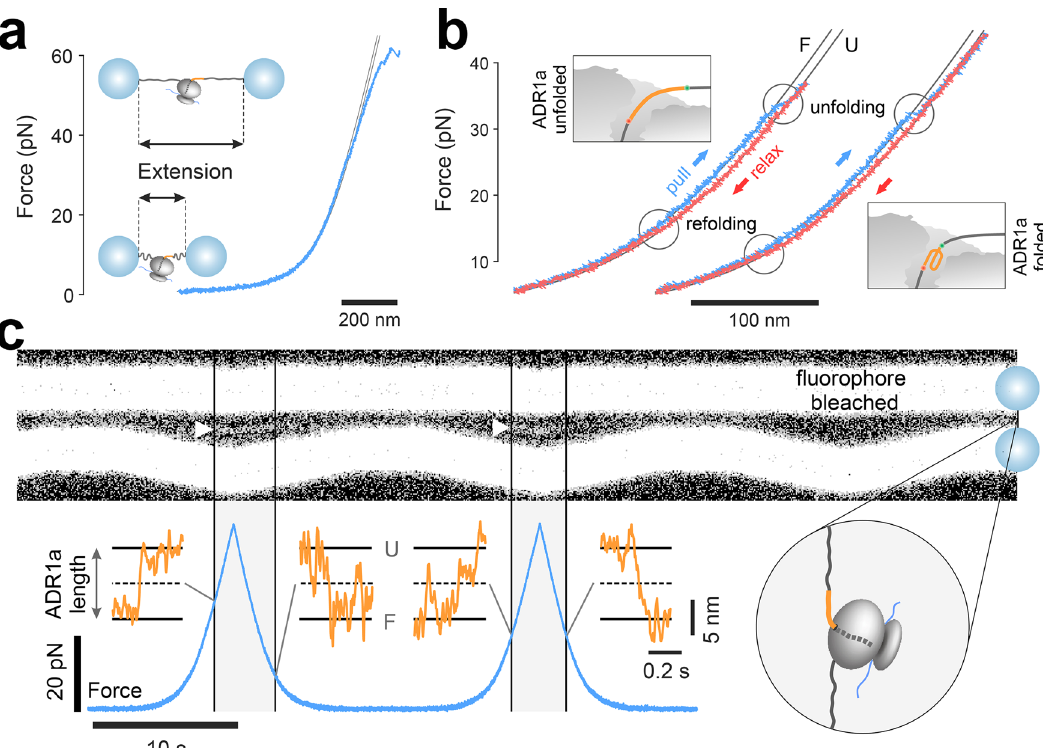
Fig. 2 Experimental force measurements. a , b Force-extension traces from a single ADR1a molecule undergoing unfolding and refolding transitions within the ribosomal tunnel ( L = 26) during repeated pull-and-relax cycles, in the presence of Zn 2 + . Blue curves represent pulling data, red curves relaxation data. Black curves are theoretical eWLC models representing the ADR1a folded (F) and unfolded (U) states. Cartoons show folded and unfolded ADR1a in the ribosomal tunnel. c Kymograph of the TAMRA donor fl uorescence signal measured in-between the optically trapped beads (indicated by the white triangles), during repeated cycles of pulling and relaxing ADR1a ( L = 26) nascent chains (top). Bottom shows corresponding force signal (blue trace). Bottom insets show the contour length of the unfolded part of ADR1a against time (orange traces), as determined using Force-Extension data, which are consistent with transitions between the unfolded (U) and folded (F) states of